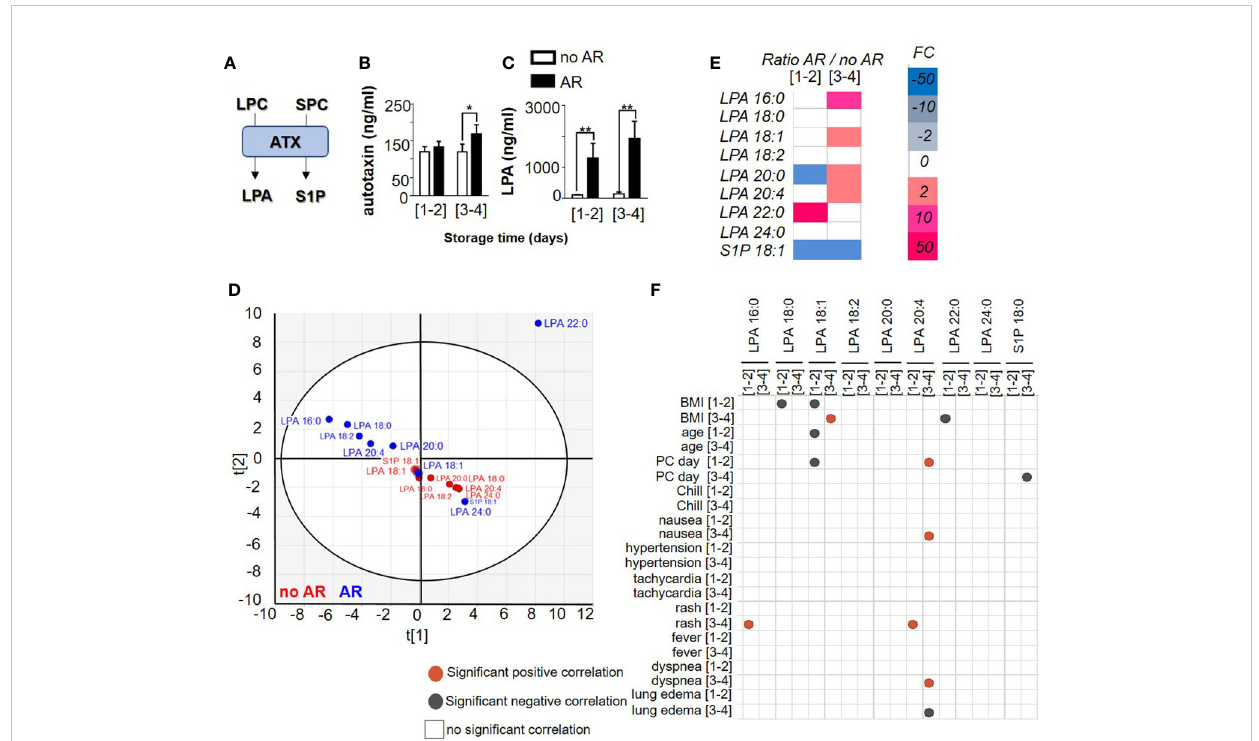
FIGURE 2 Comparison of autotaxin product pro fi le between Single Donor Apheresis platelet concentrate with or without an adverse reaction. (A) Flowchart illustrating the generation of lysophosphatidic acid (LPA) and sphingosine 1 phosphate (S1P) through ATX activities. (B) ATX expression in SDA-PC with or without AR occurrence -during storage (mean ± SEM). Statistical analysis performed with Mann Whitney test *p<0.05. (C) LPA generation in SDA-PC with or without AR occurrence during storage. The white bar represents SDA-PC without AR occurrence, and the black bar denotes SDA- PC with AR occurrence. (mean ± SEM; to refer to n patient, see Table 1). Statistical analysis performed with Mann Whitney **p<0.0001. (D) Two- dimensional score plot of a principal component analysis of LPA species and S1P from SDA-PC without occurrence of AR (red) and from SDA-PC with occurrence of AR (blue) taking all storage times into account. (E) Heat map represents fold change in mean LPA species and S1P expression between SDA-PC with occurrence of AR and from SDA-PC without occurrence of AR for the various storage times reported on the heat map. (F) Correlation matrix between ATX products and adverse reaction symptoms are built with a Pearson correlation. Grey dots represent a negative correlation and red dots a positive correlation, with the level of signi fi cance being p